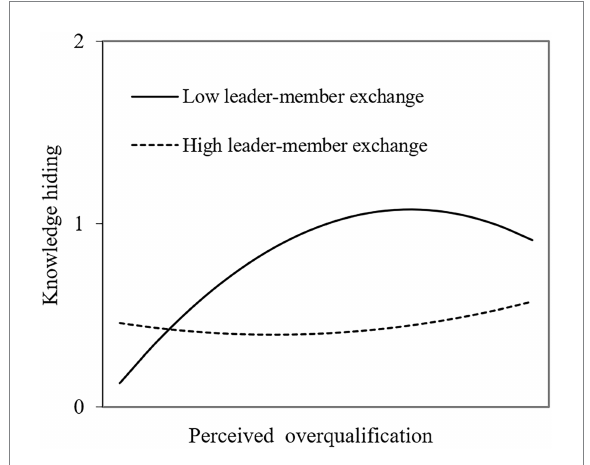
FIGURE 2 Moderating effect of leader-member